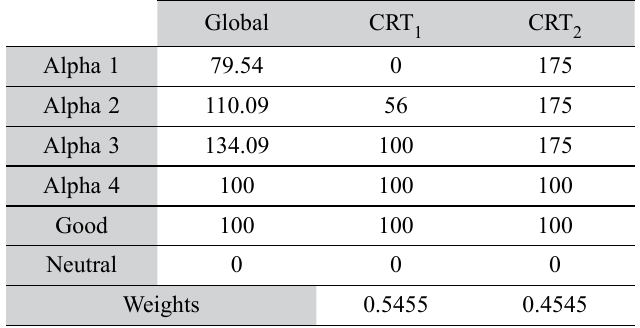
Table 4. Partial values and overall attractiveness revealed by the evaluated